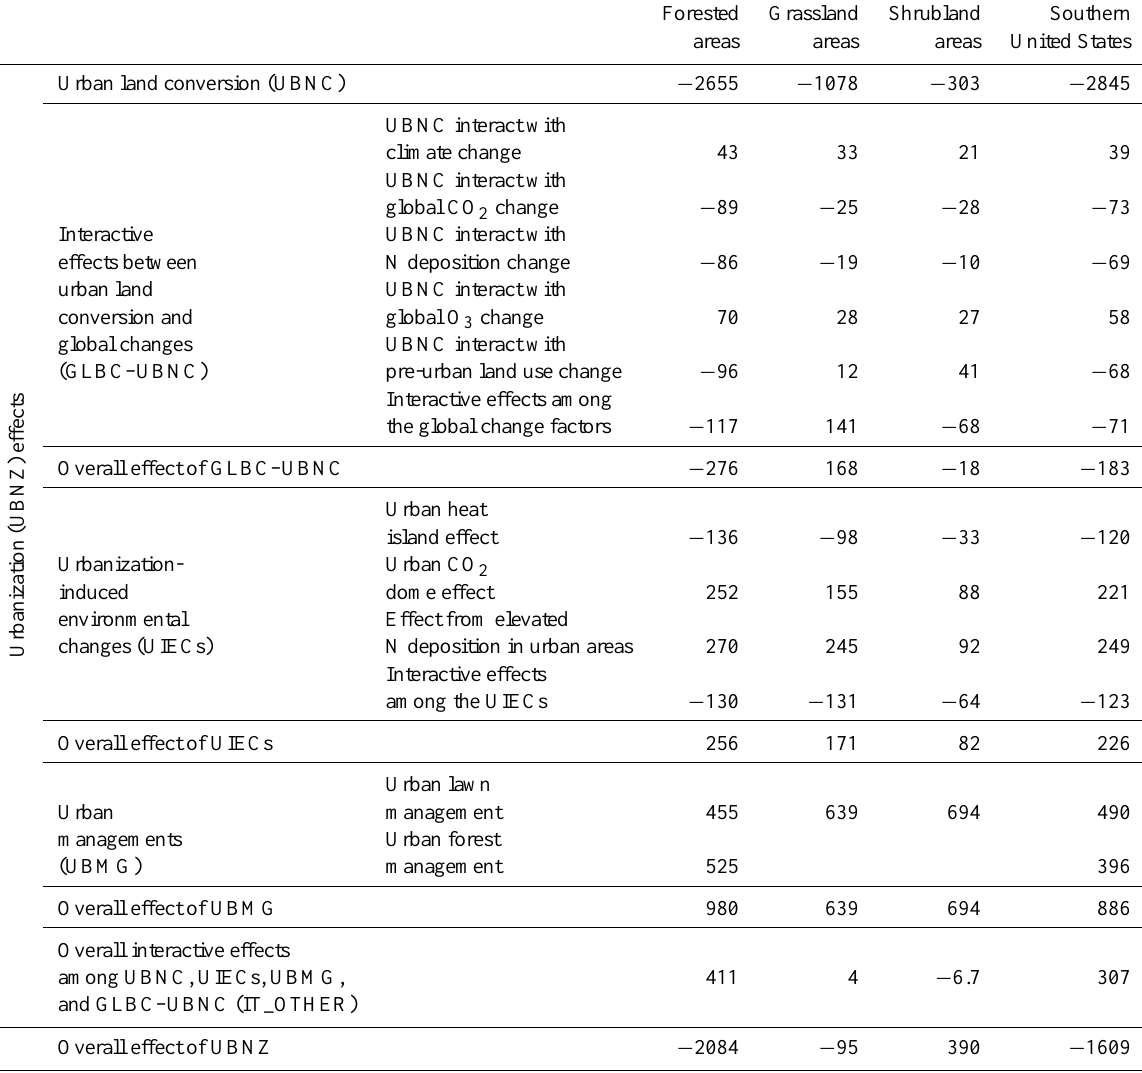
Table 3. Contributions of multiple environmental controls to urbanization (UBNZ) effect on carbon (C) dynamic of the forest (including needleleaf, broadleaf, mixture, and wetland forests), grass (including C3 and C4 grasslands, and grassy wetland), and arid shrubs (including shrubland and desert) ecosystems in the southern United States (SUS) from 1945 to 2007. Unit: gCm − 2 .